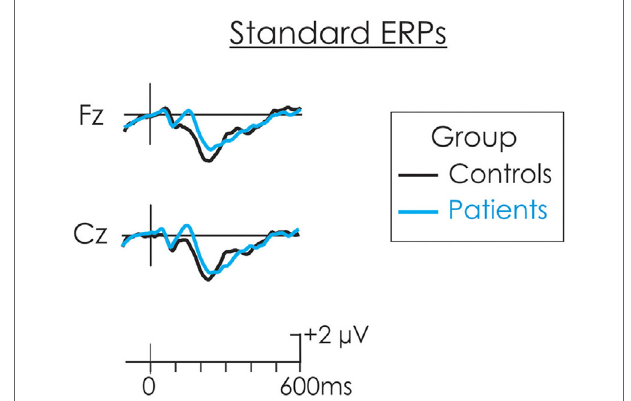
FigUre 2 | The event-related potential (ERP) waveform to the standard stimulus for both patients (blue) and controls (black). There were no significant differences in the amplitude of the N1 or P2 between patients and